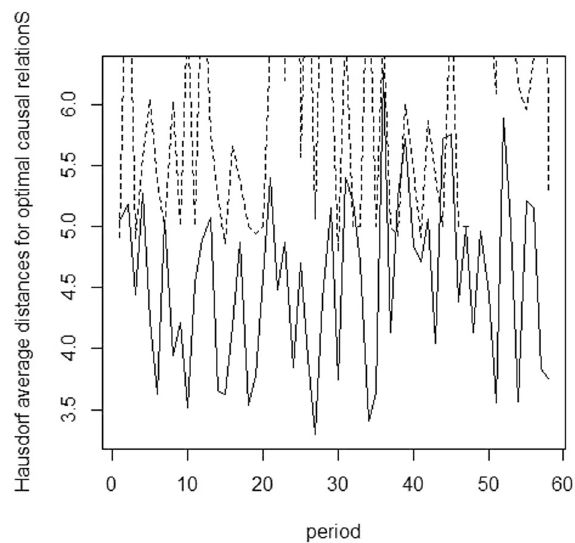
Fig. 1 Optimal causal correlation coef fi cient from MHP (or X) to MSP (or Y) or MaxCCC Y t j X t . MHP stands for Military Hard Power, while MSP stands for Monetary Soft Power. MaxCCC Y t j X t is the maximal causal correlation coef fi cient from X to Y, where t denotes t ’ th period.